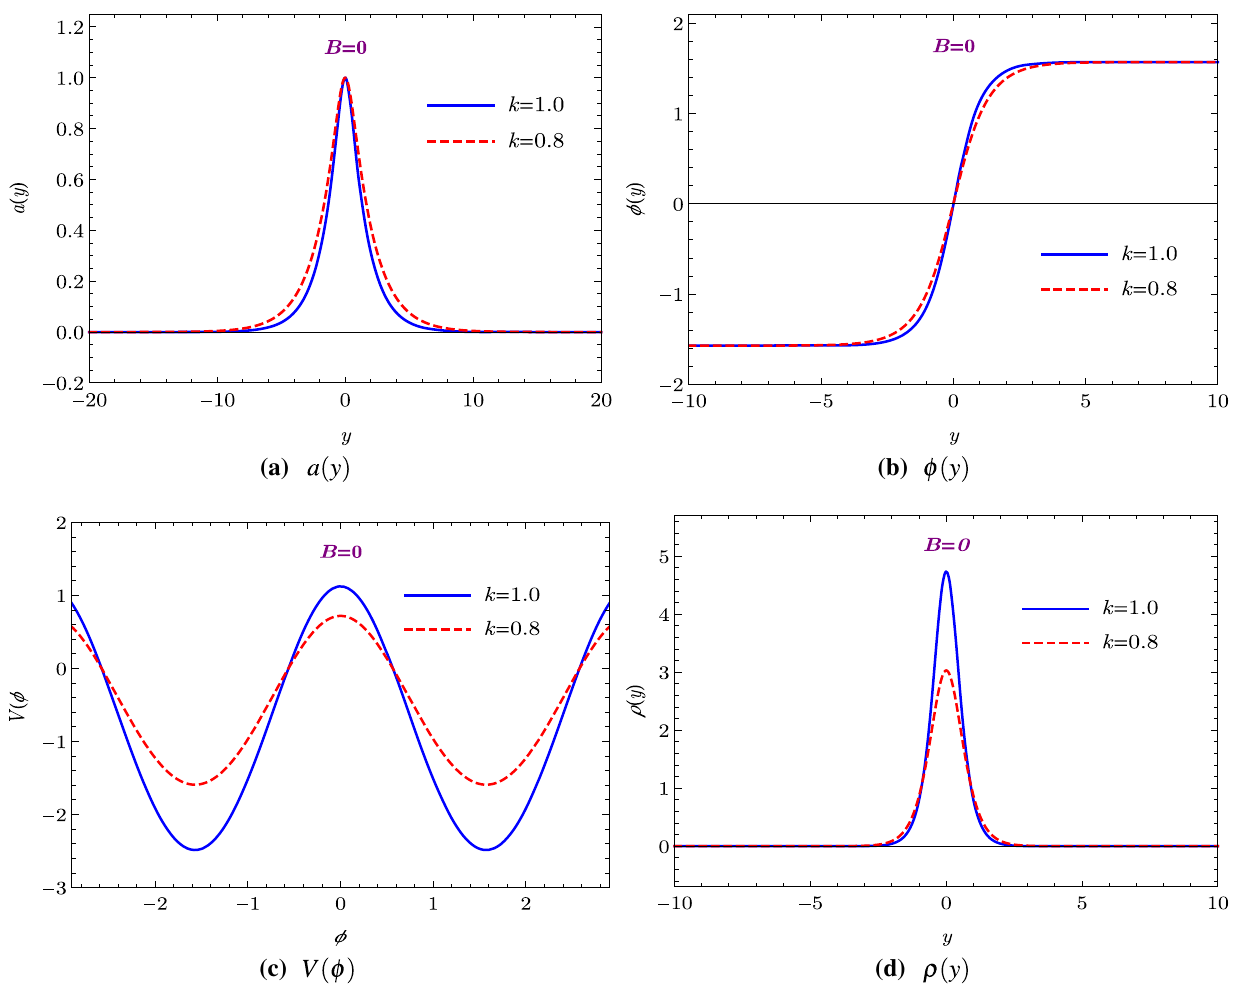
Fig. 3 The profiles of the warp factor a ( y ) , scalar field φ( y ) , scalar potential V (φ) , and energy density ρ( y ) for the case of B =